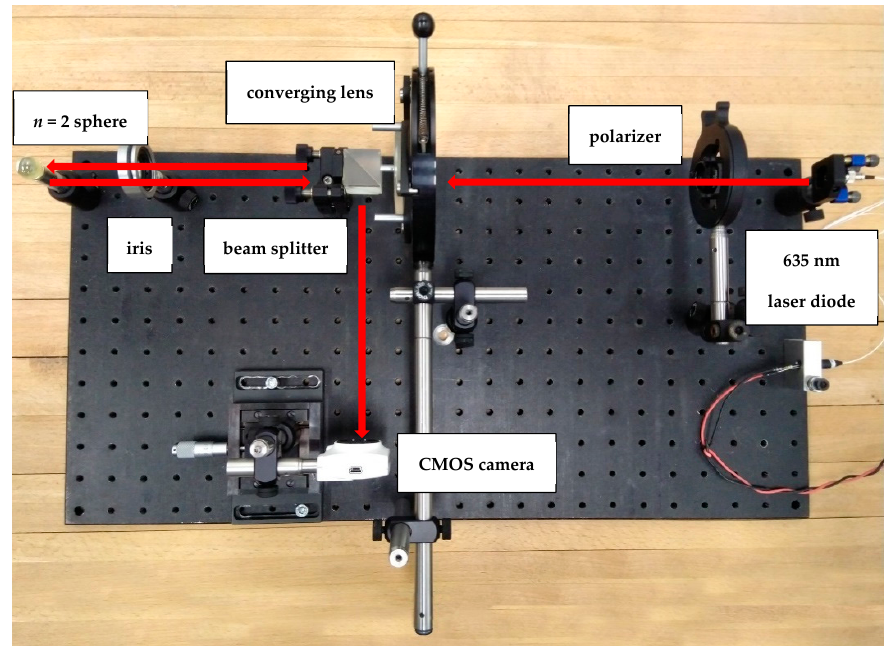
Figure 1. Setup used to study the high-index sphere as retroreflector.